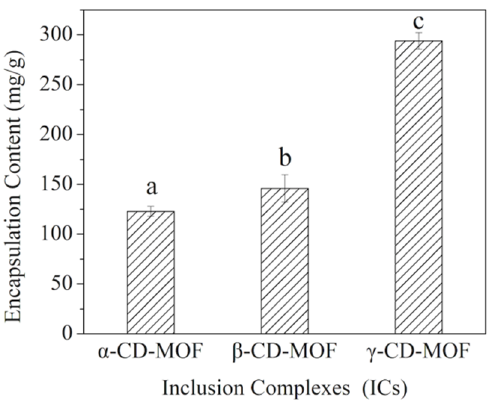
Figure 1. Encapsulation content of thymol in inclusion complexes. Different superscript letters (a–c) represent statistically significant differences ( p < 0.05).